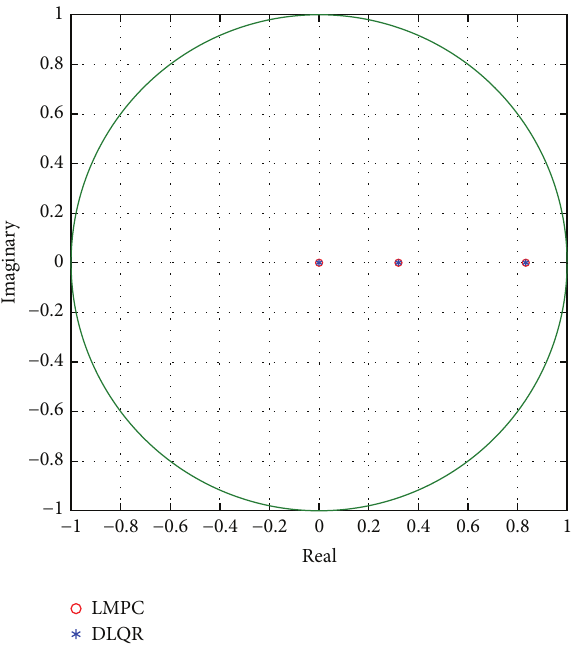
Figure 4: Eigenvalues for DLQR and LMPC in altitude control.